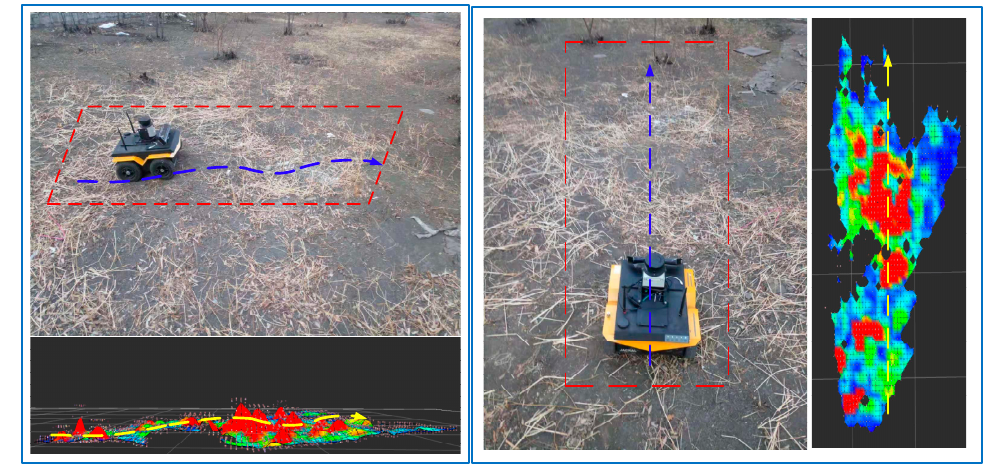
Figure 25. Outdoor test results.